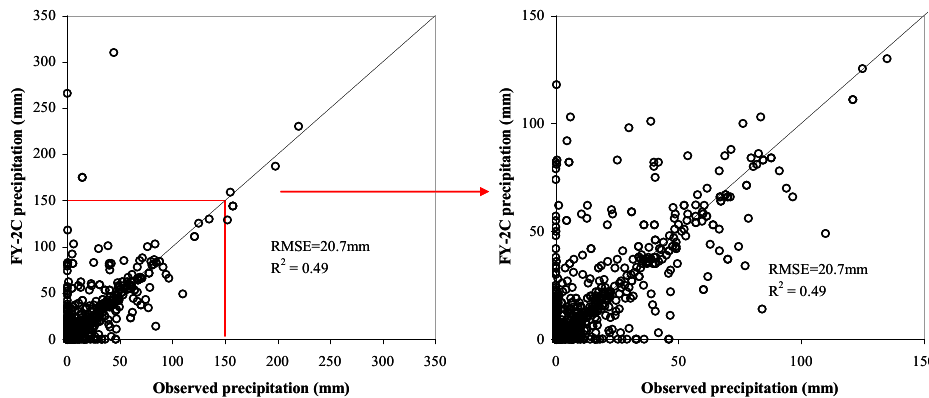
Figure 6. Comparison of weekly measured precipitation by rain gauges and estimates from FY-2C data of original data for nine stations within Hebei Province.